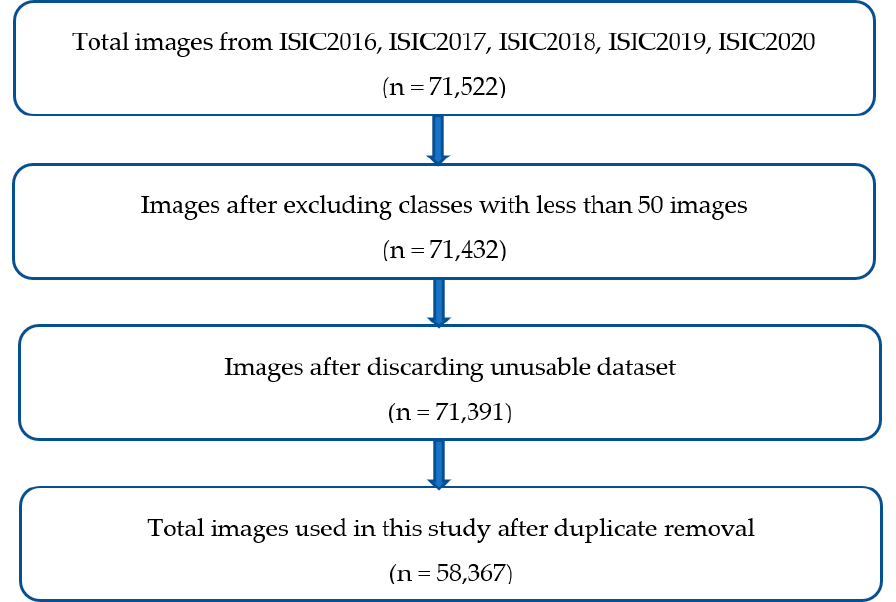
Figure 1. Inclusion and exclusion protocol for the selected skin lesion images.